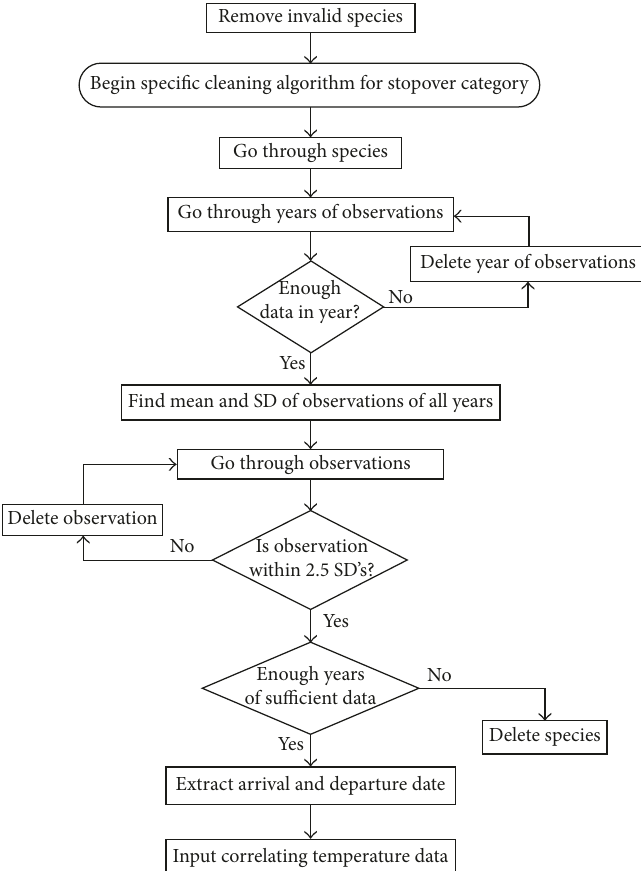
Figure 1: Flow chart of general data-cleaning